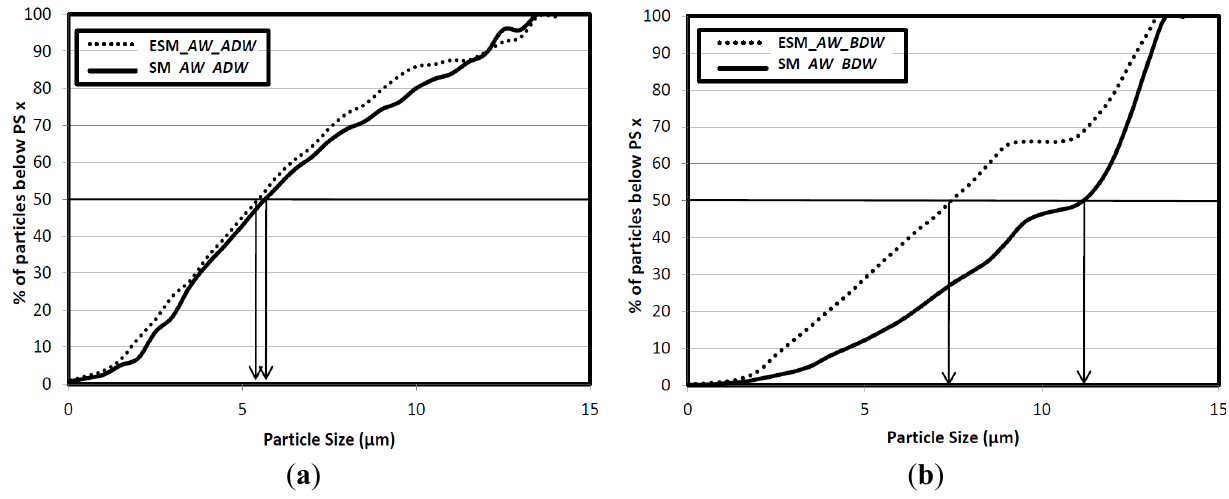
Figure 5. Particle size distribution (PSD) of ball-milled SM_AW ( _____ ) and ESM_AW (·····)